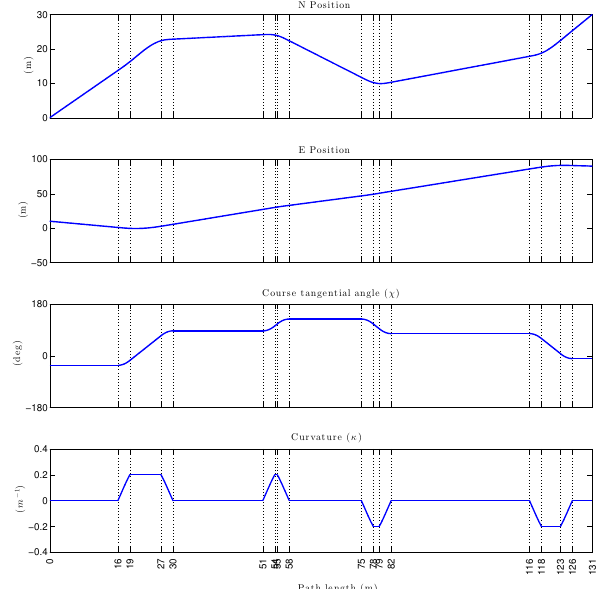
Figure 22: Dubins path with Fermat smoothing prop- erties